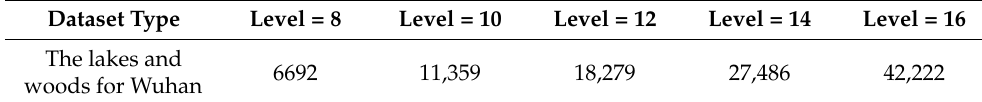
Table 3. The number of vertices at different levels for the lakes and woods for